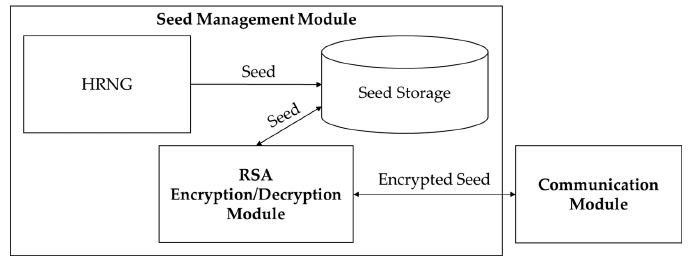
Figure 5. Seed management module structure and flows.